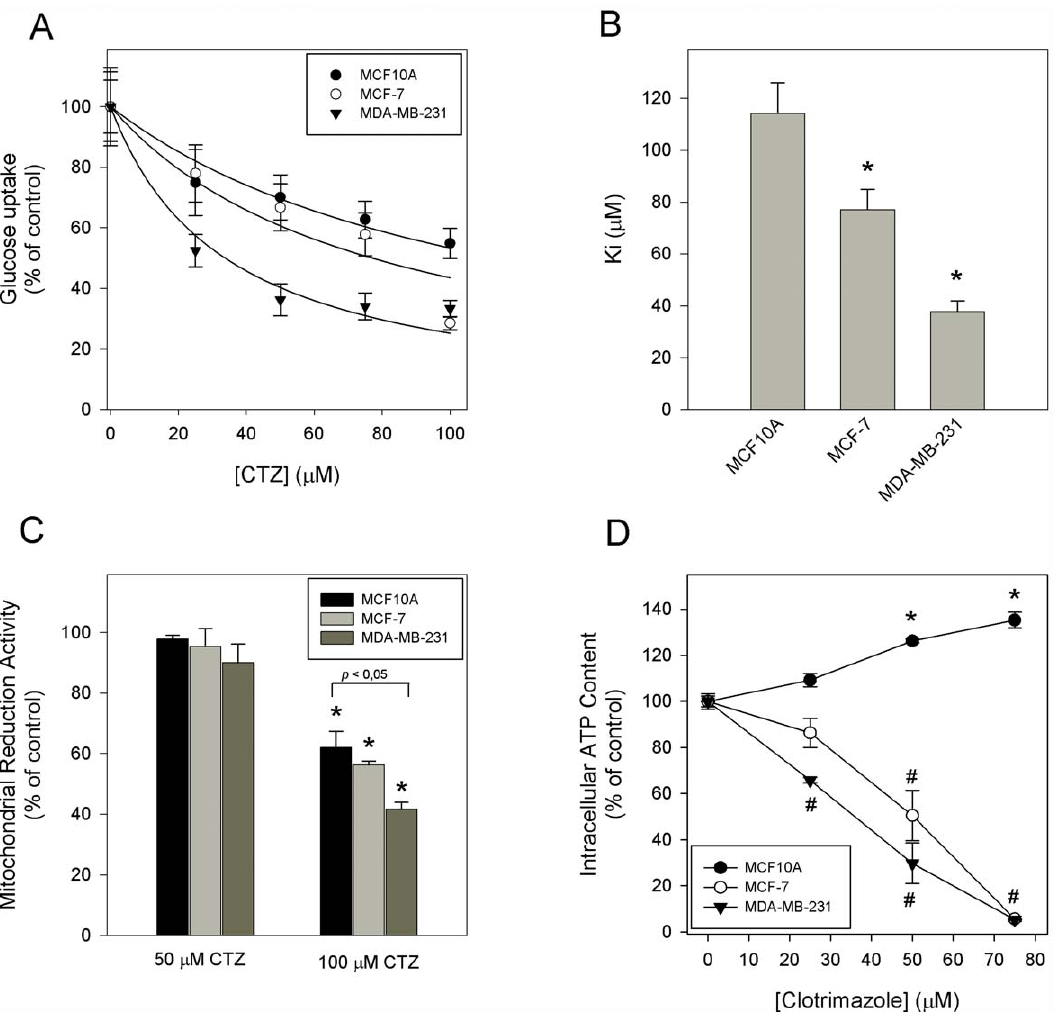
Figure 3. Effects of clotrimazole on glucose uptake, mitochondrial reduction activity and cellular ATP content in breast cell lines. (A) Comparison of glucose uptake in MCF10A, MCF-7 and MDA-MB-231 cells. Glucose uptake was determined after 15, 30 and 45 min incubation through cells incubation with 5 mM 6-NBDG, a fluorescent glucose analogue. The results obtained are plotted as percentage of control in a function of clotrimazole concentration. (B) Glucose uptake experimental data was fitted in an equation as described in Methods and the K i values were plotted. Bars are mean 6 SEM of three independent experiments. * P , 0.05, comparing with MCF10A cells. (C) Percent of mitochondrial reduction activity, evaluated by MTT assay. All values were normalized to that of control condition in the absence of the drug. (D) Intracellular ATP content measured by relative firefly luciferase activity (PerkinElmer ATPLite Kit). Error bars represent standard errors from five independent experiments. * P , 0.05 compared to control for MCF10A cells. # P , 0.05, compared to control for MCF-7 and MDA-MB-231 cell lines.